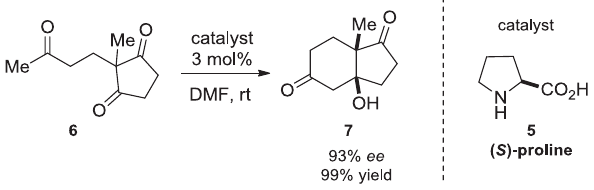
Figure 3. Asymmetric aldol reaction catalyzed by ( S )-proline, see Ref. [27,